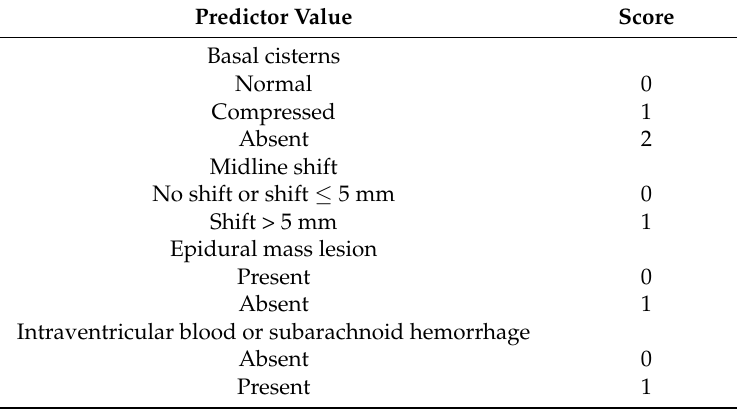
Table 3. Rotterdam CT score. In adults, mortality at six months increases with the score; score 1: